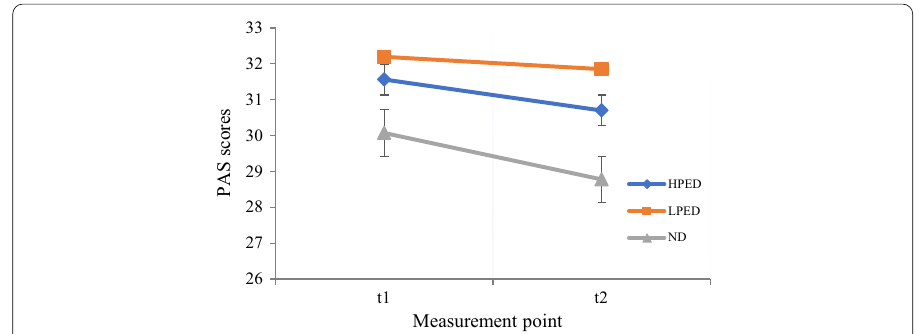
Fig. 2 PAS values on the first and second measurement point for the three groups